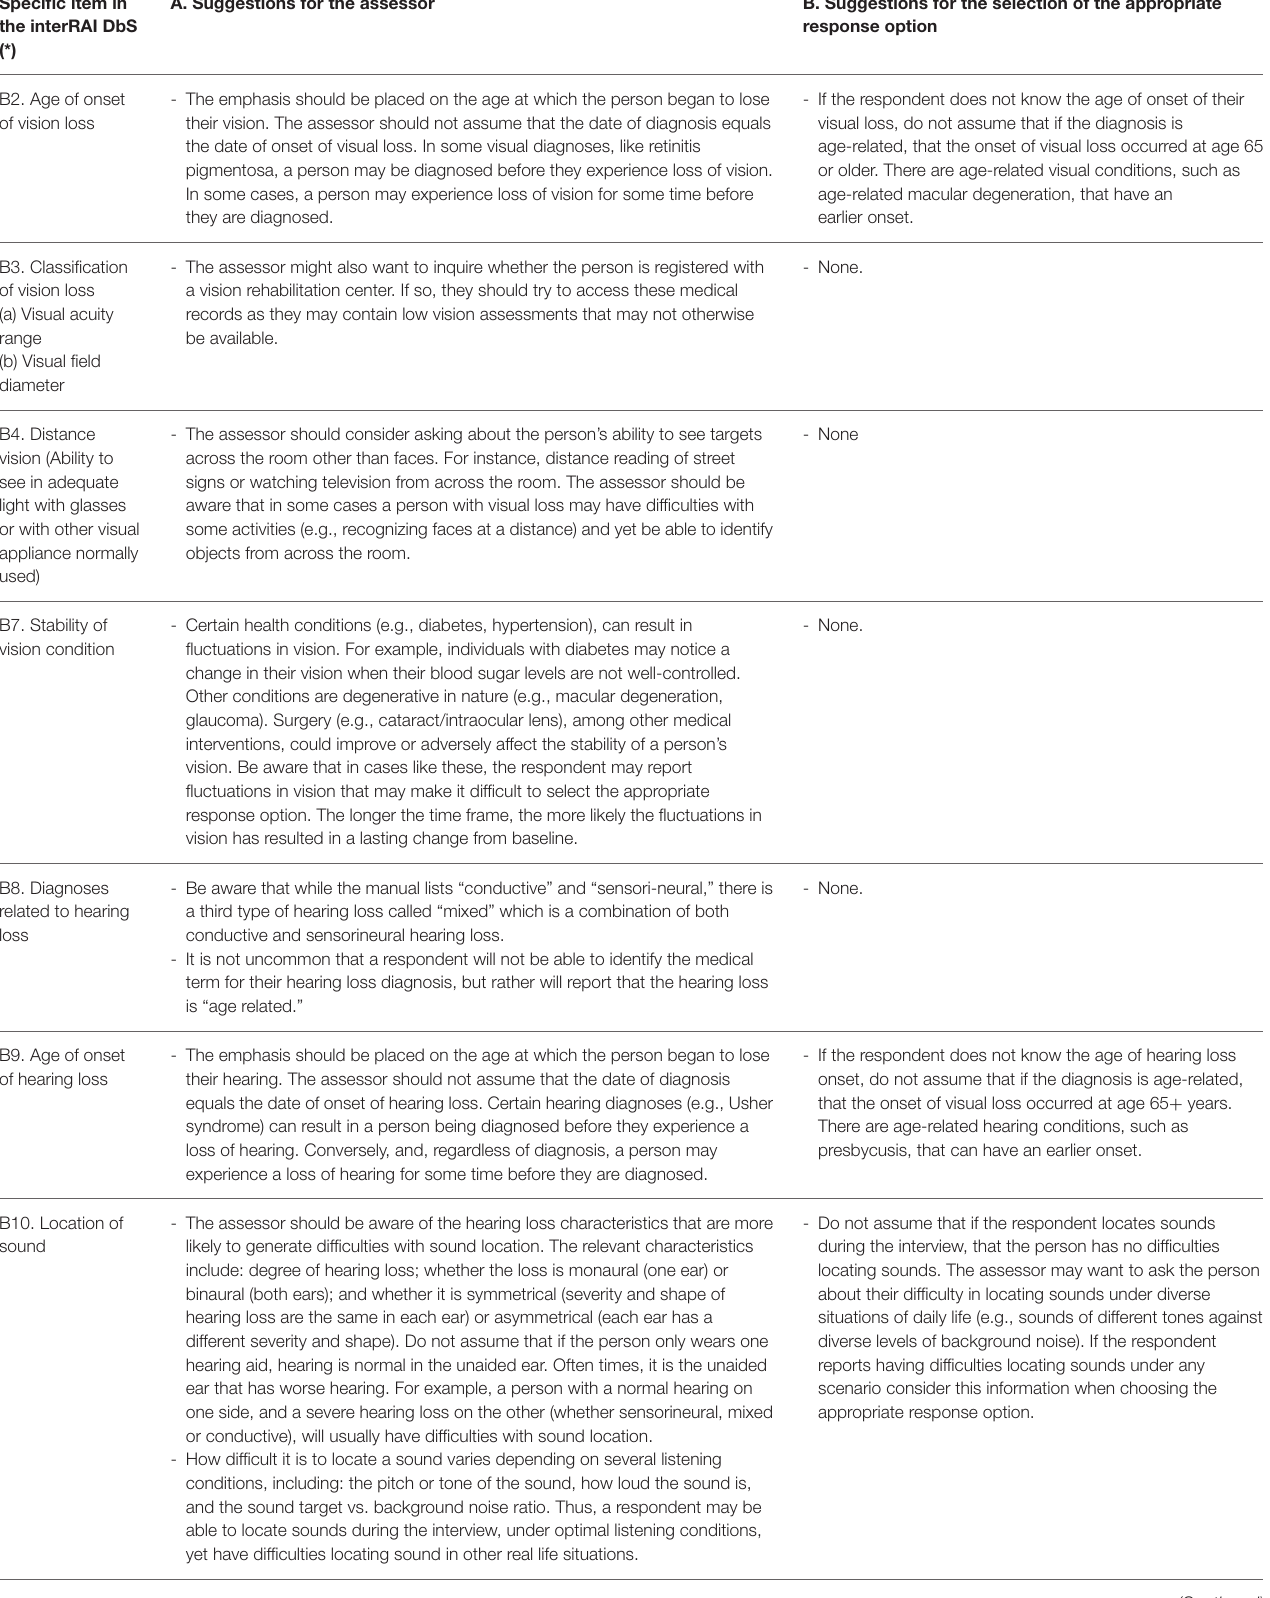
TABLE 3 | Supplemental guidelines for completing section B (Vision and Hearing) within the Deafblind Supplement (DbS). Specific item in the interRAI